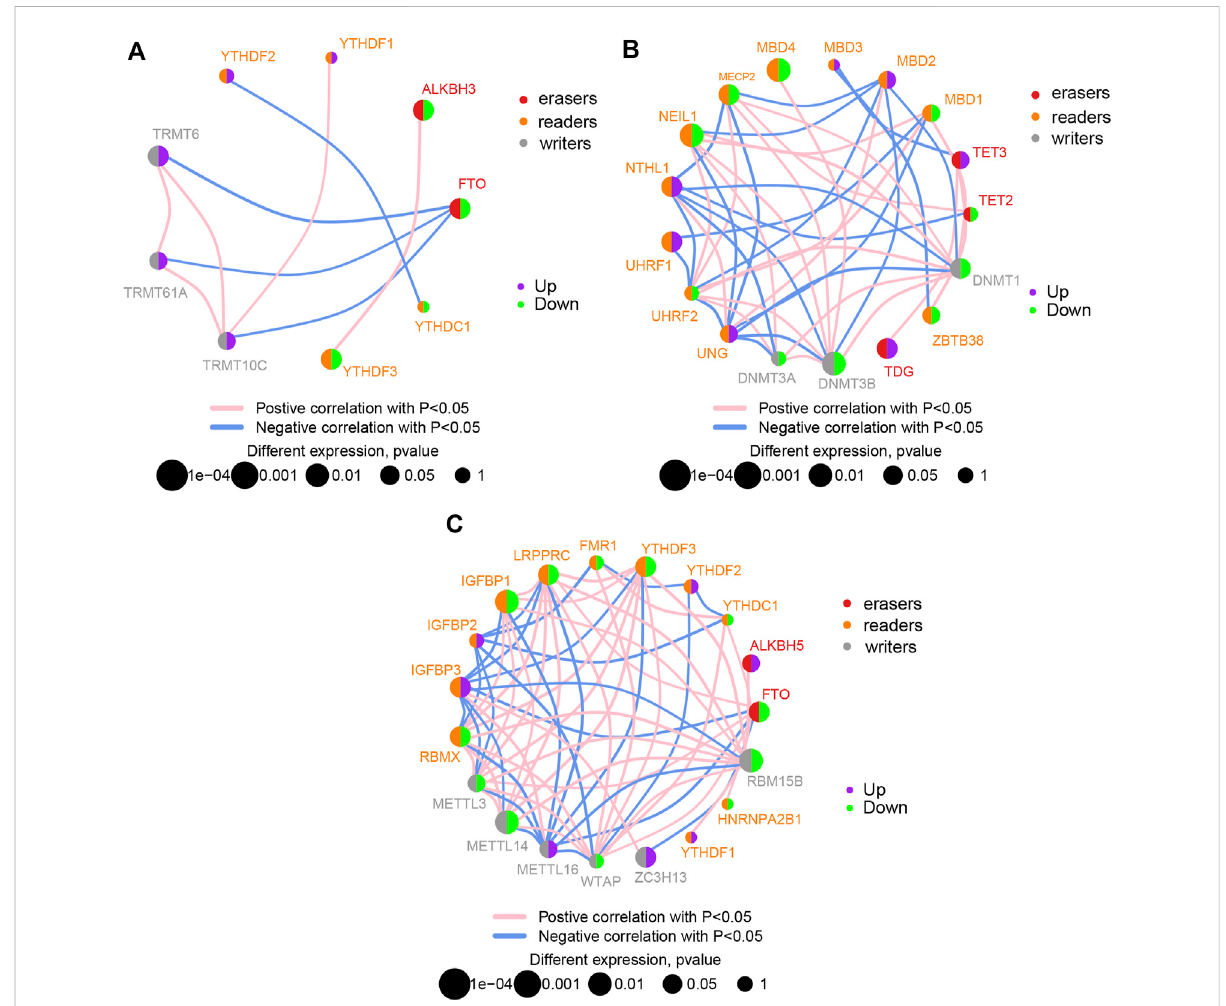
FIGURE 2 Correlationbetweendifferentiallyexpressedgenes.Correlation networkdiagramofdifferentiallyexpressedm1Aregulators (A) ,m5Cregulators (B) , and m6A regulators (C) in ischemic stroke